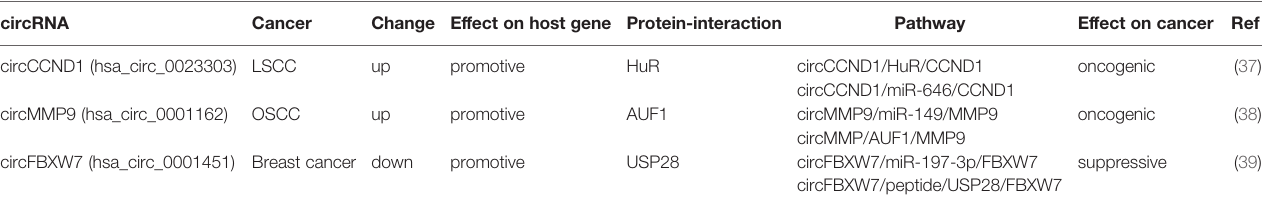
TABLE 4 | Diverse regulatory effects of circRNAs on host gene in human cancer.